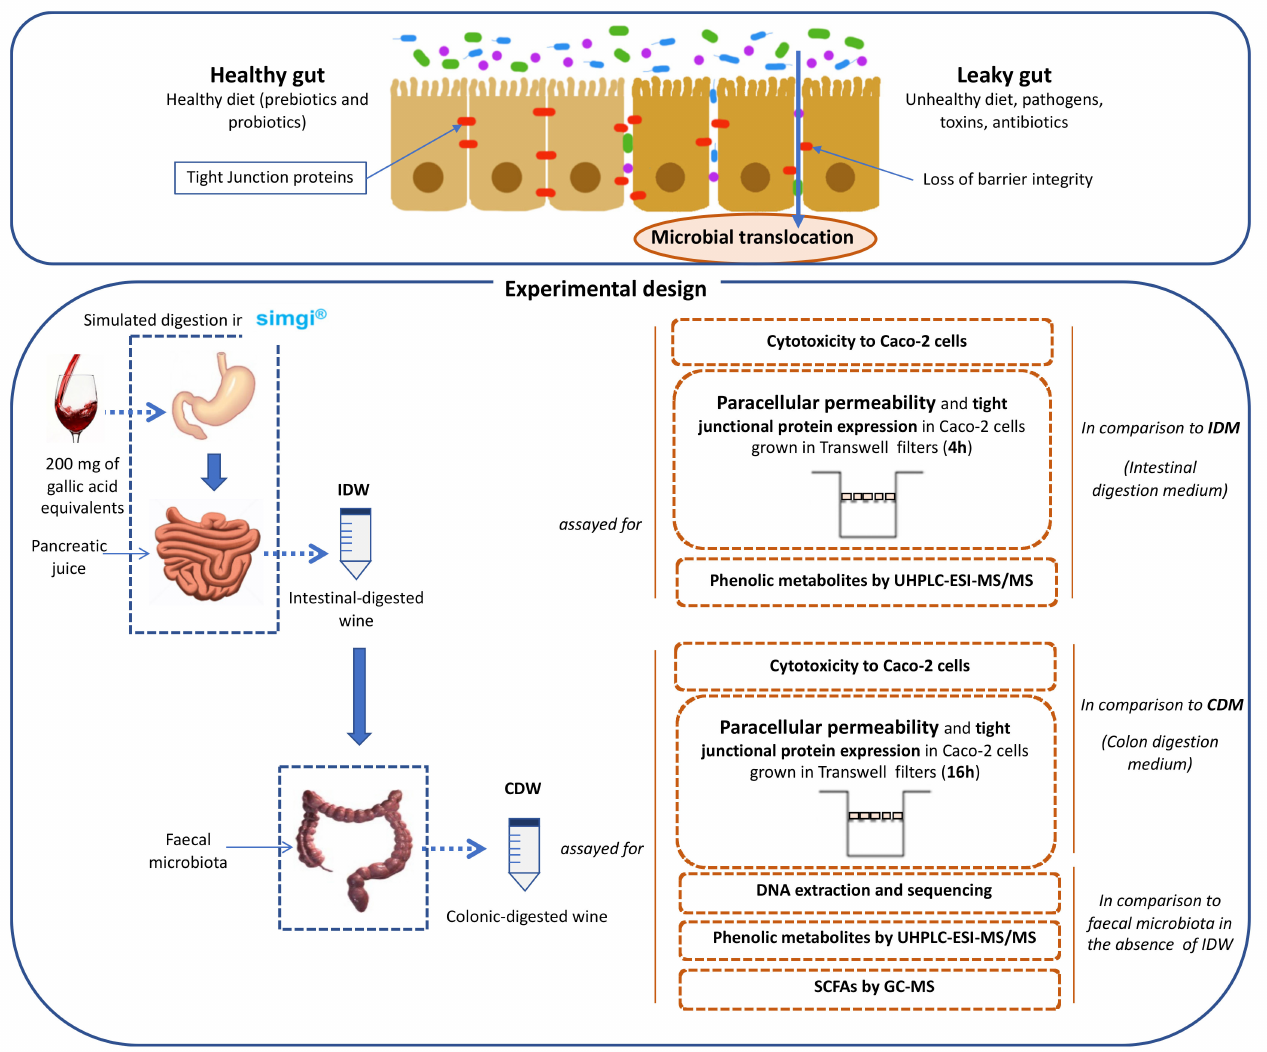
Figure 1. Scheme for the obtention of digested-wine fluids (IDW and CDW) and the study of their effects on intestinal permeability and gut